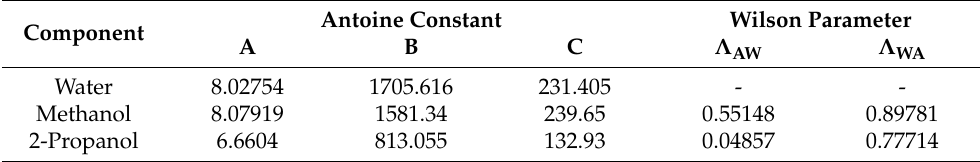
Table 1. Antoine constants and Wilson parameters of components of pervaporation test solutions [15]. Component